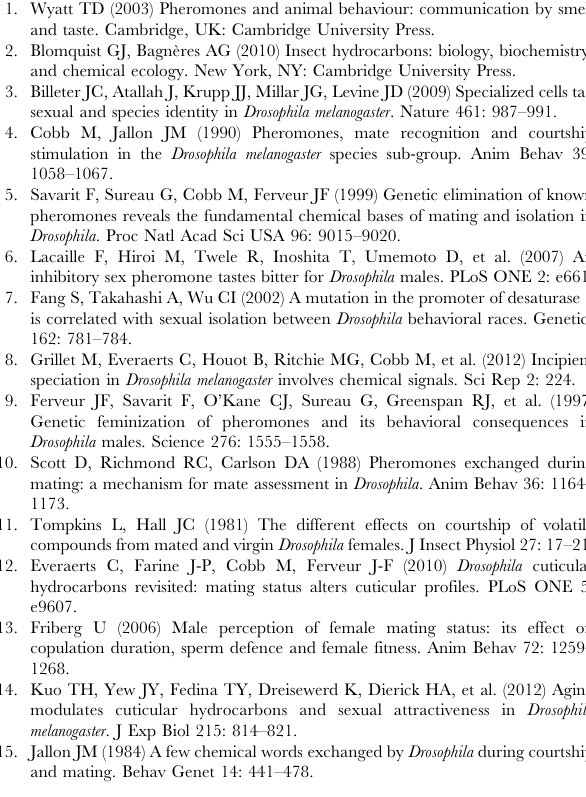
and oe 2 females perfumed with the CHCs of white females. Internal standards are marked on the chromatograms with a ‘‘*’’. Note that the y-axis is scaled differently for the white females. (TIFF) Figure S2 D. melanogaster male preferences when paired with oe 2 and oe + females. Preference indices for D. melanogaster males from 12 inbred genotypes and one outbred population (allRAL) when allowed to choose between oe + females (expressing CHCs) and oe 2 females (lacking CHCs). The preference index is the relative advantage of oe 2 females over oe + females, such that positive values indicate a preference for females lacking CHCs. Asterisks above the columns show preference indices that are significantly different from 0 (binomial tests: * p , 0.05; ** p= 0.0001 and significant after sequential Bonferroni adjustment). N (Canton-S) =71, all other n= 23–54.